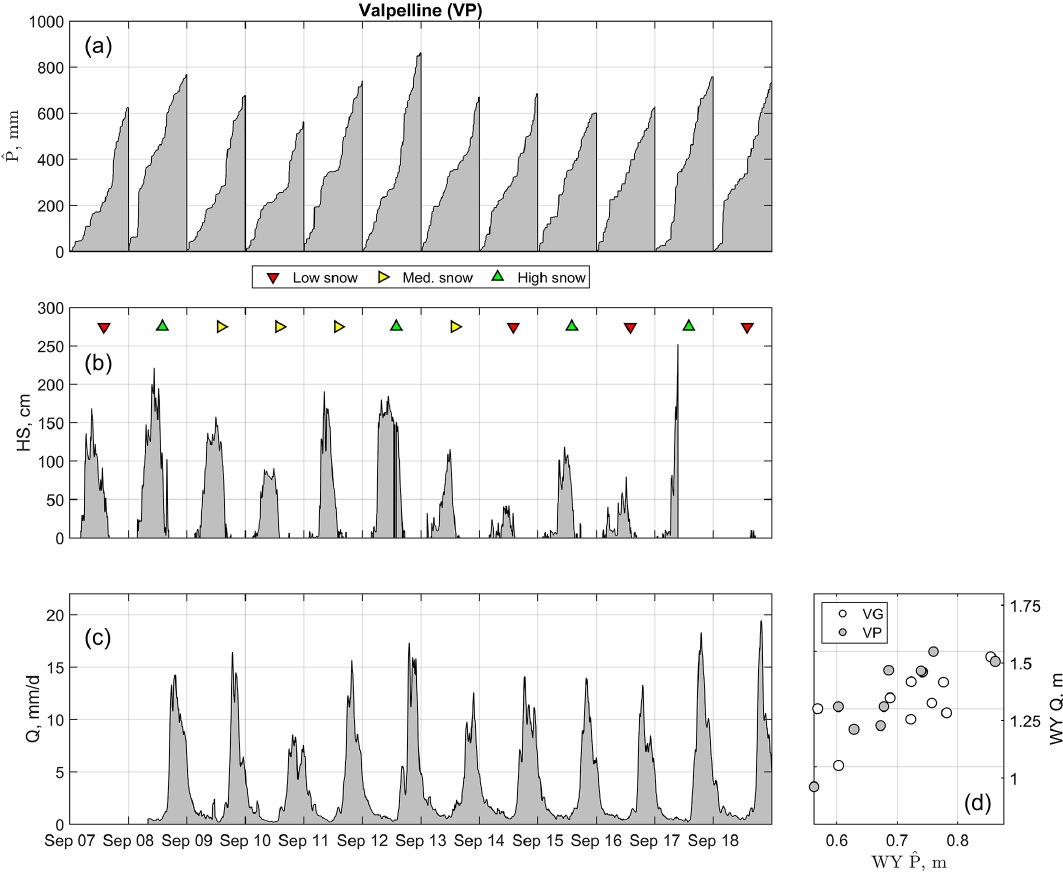
Figure 3. Summary of daily precipitation (a) , snow depth (b) , and reconstructed streamflow (c) for Valpelline. Precipitation was calculated across all gauges in the valleys of Valpelline (variable ˆ P ; see gauge locations in Fig. 1). Snow depth was from a representative, mid-elevation sensor (elevation was ∼ 1970ma.s.l.). Reconstructed streamflow refers to the hydropower catchment delineated in Fig. 1. Low, medium, and high snow seasons were estimated based on percentiles of mean seasonal snow depth at Beauregard, which had a complete record between water years 2008 and 2019 (Fig. S14). Any water year with mean seasonal snow depth below the 33 ◦ percentile was classified as a low snow water year, while medium snow water years had a mean seasonal snow depth between the 66 ◦ and the 33 ◦ percentiles, and high snow water years had a mean seasonal snow depth above the 66 ◦ percentile. This classification is only functional with respect to the scope of this paper and has no long-term climatological implications. Note that ephemeral snow water years at these mid-elevation snow stations were not attributed to any of these classes a priori, although it is likely that ephemeral snow water years also have a low mean seasonal snow depth. (d) The estimated precipitation–runoff relationship for both hydropower catchments, where WY ˆ P and WY Q are water year cumulative precipitation and reconstructed streamflow, respectively ( ˆ P is systematically smaller than Q because high-elevation headwaters are